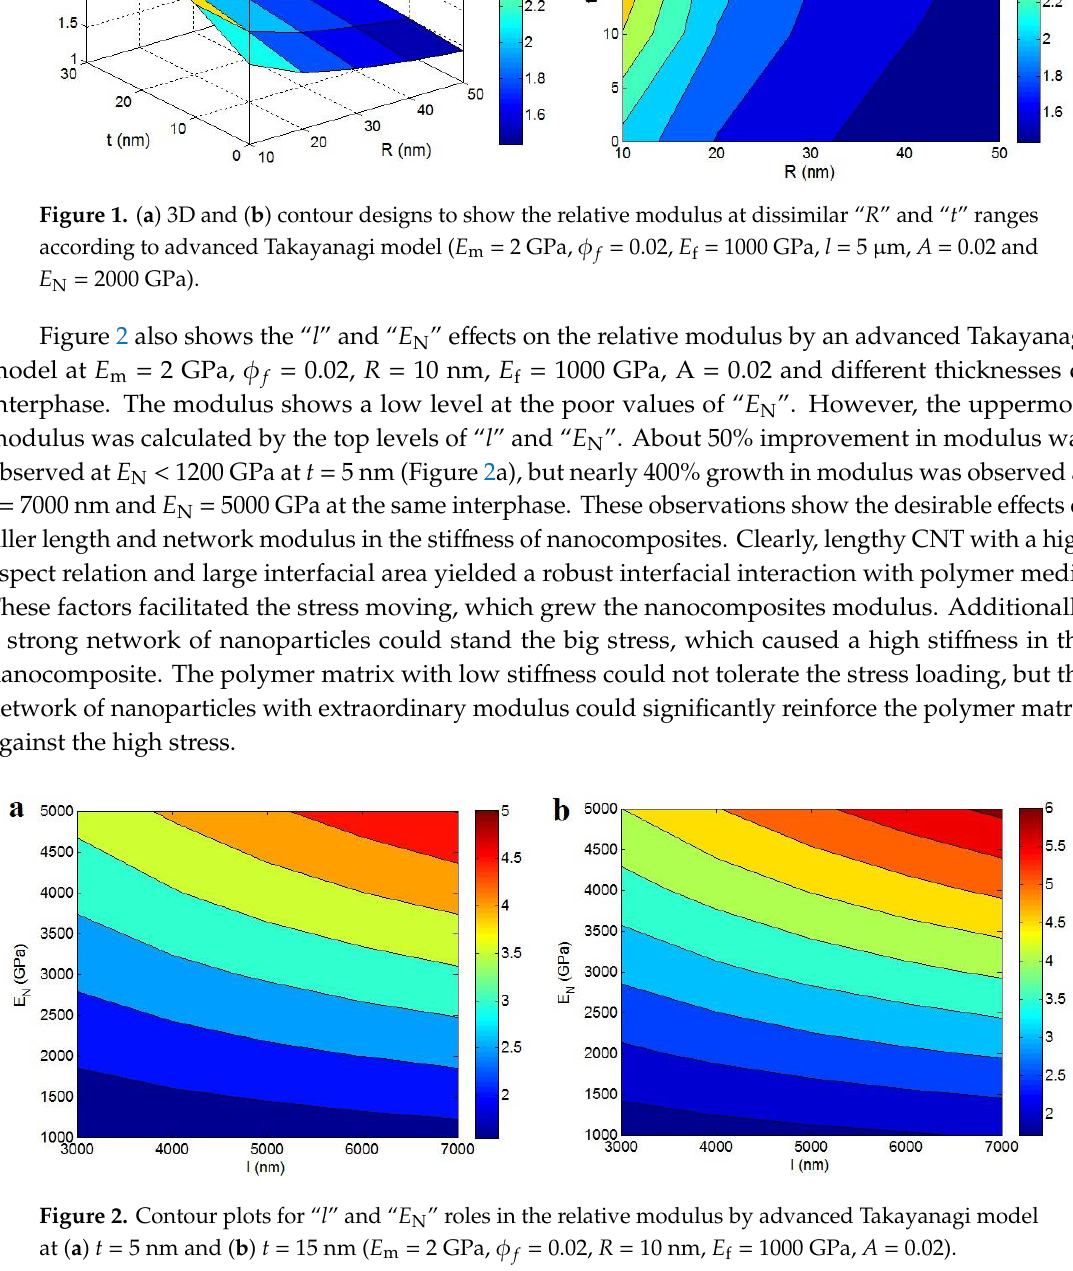
= 0.02, R = 10 nm, E f = 1000 GPa, A = 0.02). f